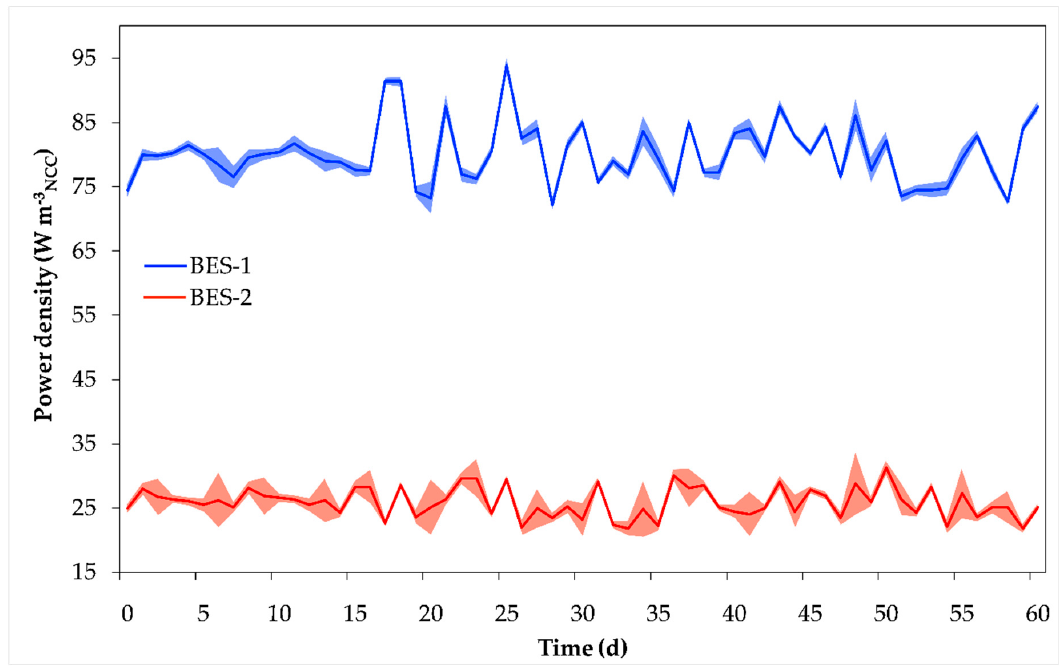
Figure 4. Power density recorded during the experimentation. Shaded areas represent the standard deviation of the daily values.